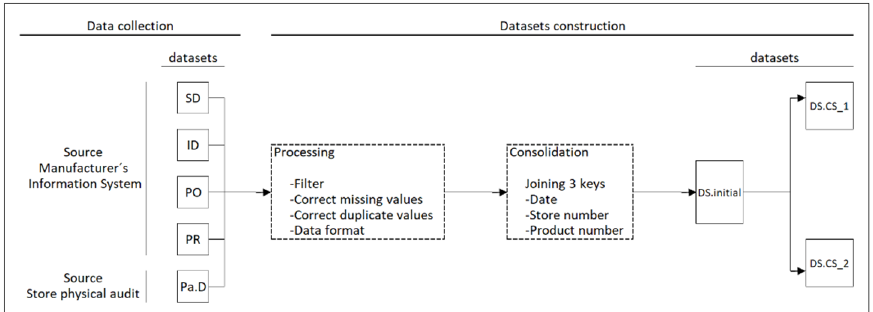
Figure 3. Data collection and datasets definition.